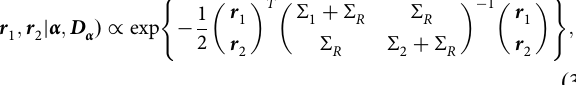
single trajectories, using all the information contained in the data and thus achieving greater precision.